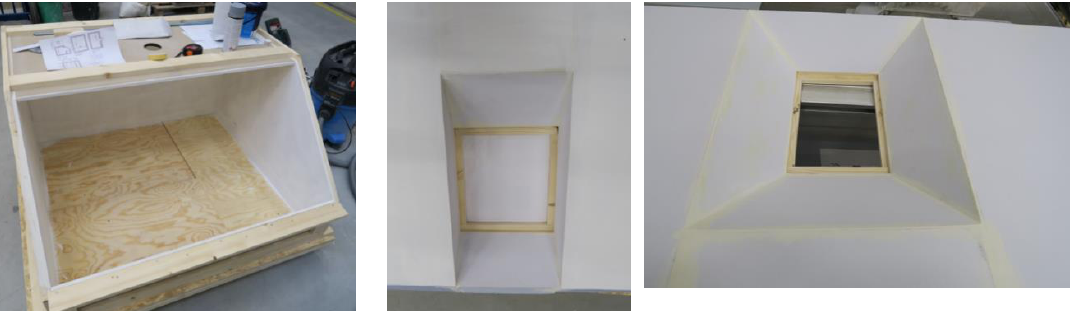
Figure 8. Model of a room for daylight measurement with changeable pitched roof.